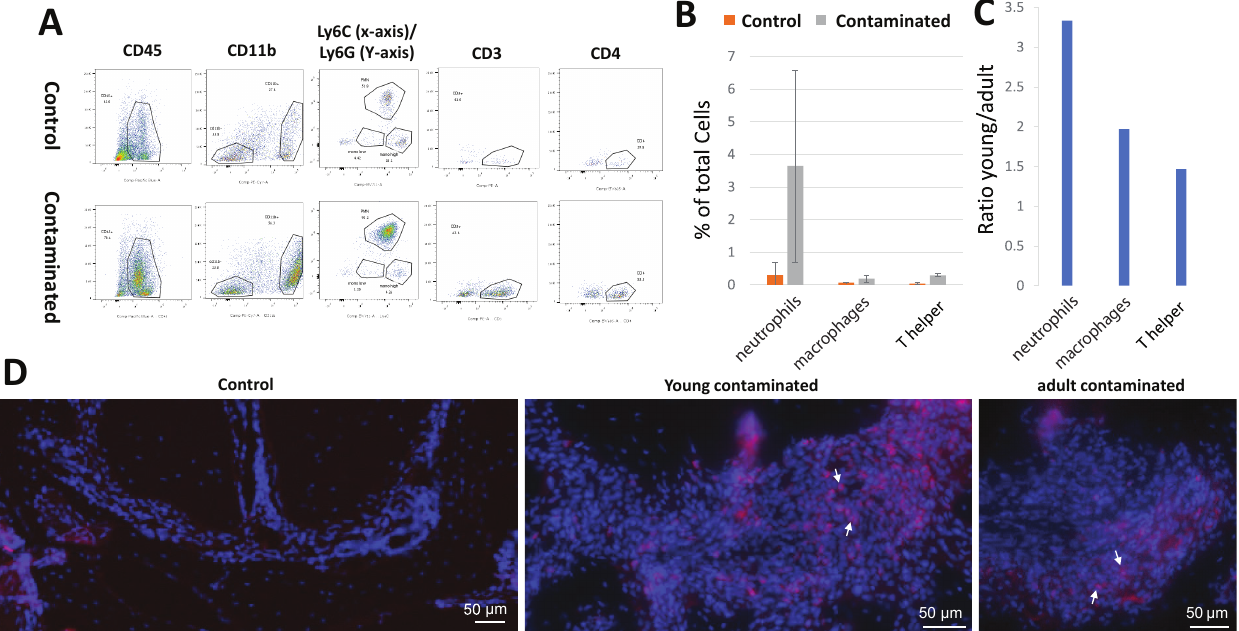
Figure 4. Cellular composition of the lesions. Cells were extracted from the periapical region, stained for immune markers, and analyzed by flow cytometry. ( A ) Representative gating for a panel of immune cells in the control and contaminated teeth; total cells were gated for CD45 (representing all immune cells), CD45+ cells were gated for CD11b+ (myeloid cells) and CD11b- (lymphoid cells). CD11b+ cells were gated for Ly6C (macrophages), and Ly6G (neutrophils). CD11b- cells were gated for CD3 (T lymphocytes). CD3+ cells were gated for CD4 (T helper cells). ( B ) Percentage of the different immune cell types comparing control to contaminated teeth in the young group. ( C ) Ratio of the immune cells between the young and adult contaminated teeth. ( D ) Immunofluorescent staining for Ly6G of the periapical regions of control (young), and contaminated (young and adult teeth). White arrows point to stained cells